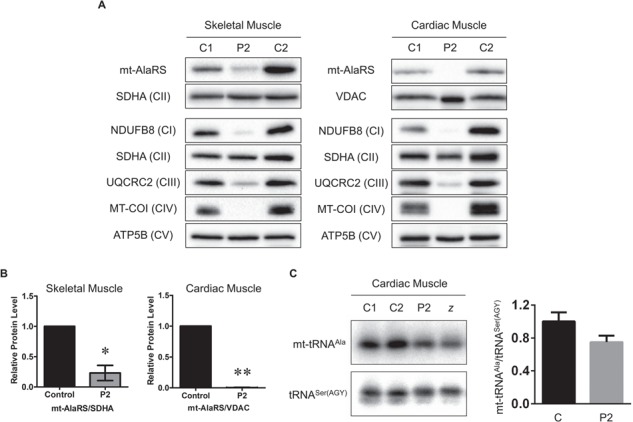
Western blot and northern blot analysis in AARS2 patient skeletal and cardiac muscle homogenates. (A) Steady-state mt-AlaRS and OXPHOS subunit protein levels in Patient 2 skeletal and cardiac muscle homogenates. Antibodies against mt-AlaRS, NDUFB8 (CI), SDHA (CII), UQCRC2 (CIII), MT-COI (CIV) and ATP5B (CV) were used, with SDHA as a loading control. (B) Graphs of relative mt-AlaRS protein levels in control and Patient 2 (P2) skeletal (n = 3) and cardiac muscle (n = 2) homogenate. All data were normalized to SDHA (skeletal muscle) or VDAC (cardiac muscle) and represented as mean ± standard error of the mean. Significant difference between controls and patient homogenates is indicated by asterisks above the columns (*, P-value < 0.05; **, P-value < 0.01 by two-tailed paired students t-test). (C) Northern blot analysis of mt-tRNAAla levels in Patient 2 and Patient z who was homozygous for the p.Arg592Trp founder mutation, corresponding to Patient 1 in (19). Mitochondrial tRNASer(AGY) was used as a loading control.